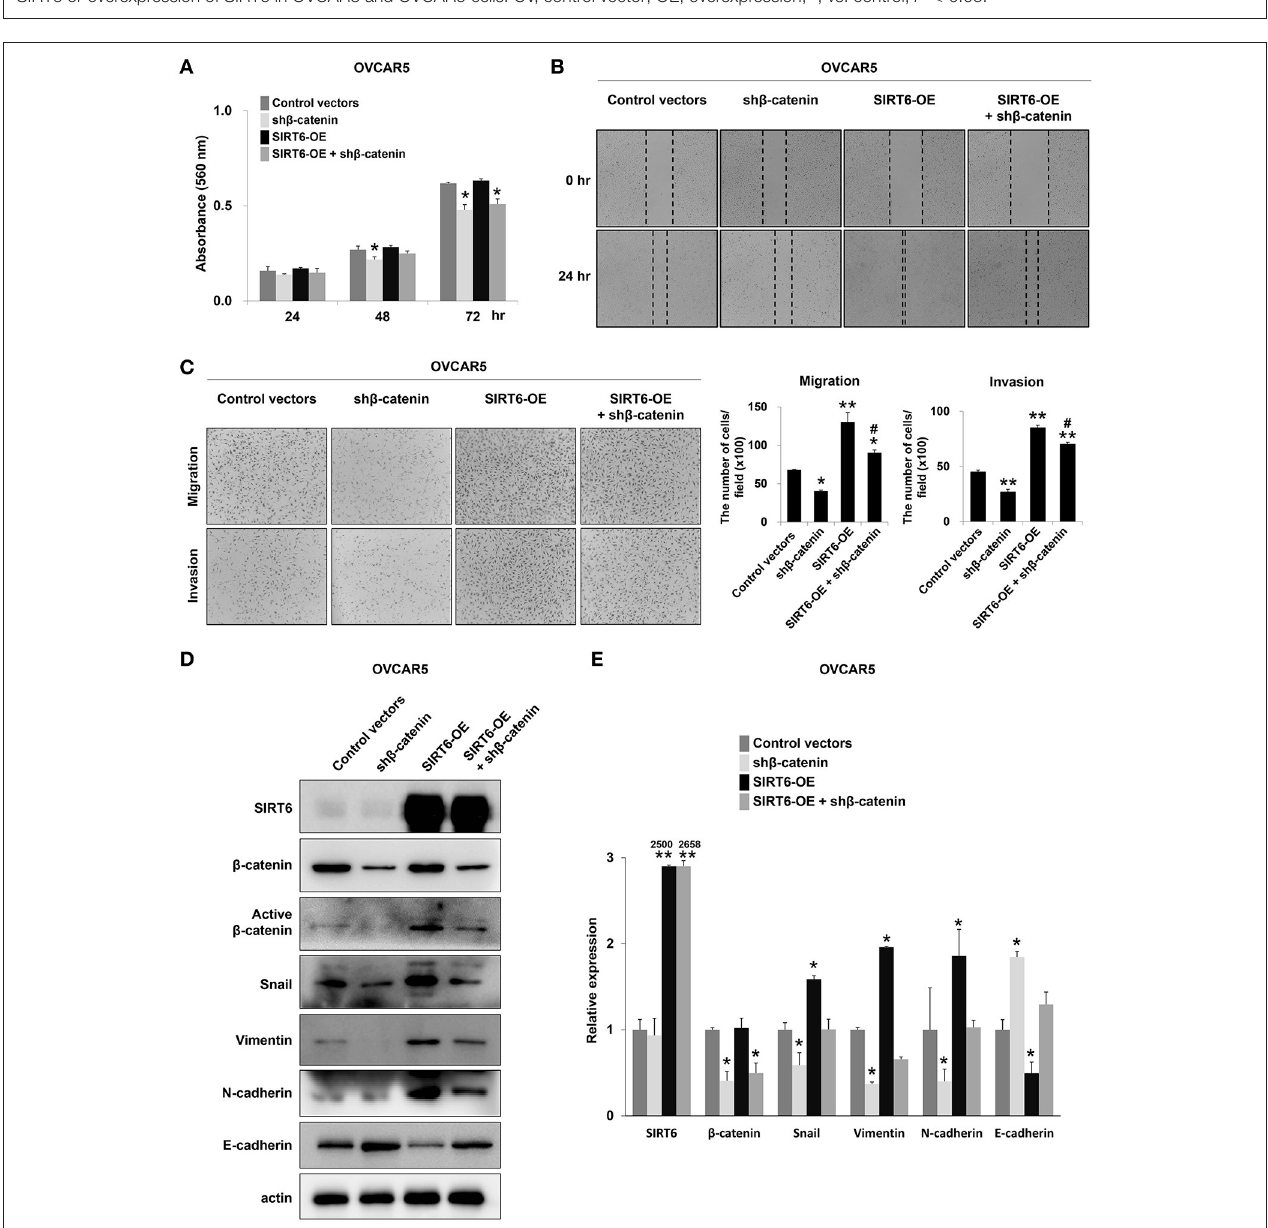
FIGURE 5 | Knock-down of β -catenin attenuates the effect of SIRT overexpression in invasion activity of ovarian cancer cells. (A) The MTT assay was performed after overexpression of SIRT6 with or without knock-down of β -catenin. (B,C) SIRT6 was overexpressed via a plasmid containing wild-type SIRT6 and β -catenin was knocked-down with shRNA for β -catenin in OVCAR5 ovarian cancer cells. Wound healing assays (B) , and migration and invasion assays (C) were performed after overexpression of SIRT6 with or without knock-down of β -catenin in OVCAR5 cells. The number of cells which migrated or invaded the chambers were counted in five microscopic fields per well at one-hundred magnification. (D) Western blotting was performed for SIRT6, β -catenin, active β -catenin, snail, vimentin, N-cadherin, E-cadherin, and actin after overexpression of SIRT6 with or without knock-down of β -catenin in OVCAR5 cells. (E) The mRNA expression patterns for SIRT6, β -catenin, snail, vimentin, N-cadherin, and E-cadherin were analyzed via quantitative reverse-transcription polymerase chain reaction after overexpression of SIRT6 with or without knock-down of β -catenin in OVCAR5 cells. CV, control vector; OE, overexpression; the P values were calculated by one-way ANOVA with LSD test; *, vs. control; P < 0.05, **, vs. control; P < 0.001, # , vs. SIRT6 overexpression; P < 0.05.